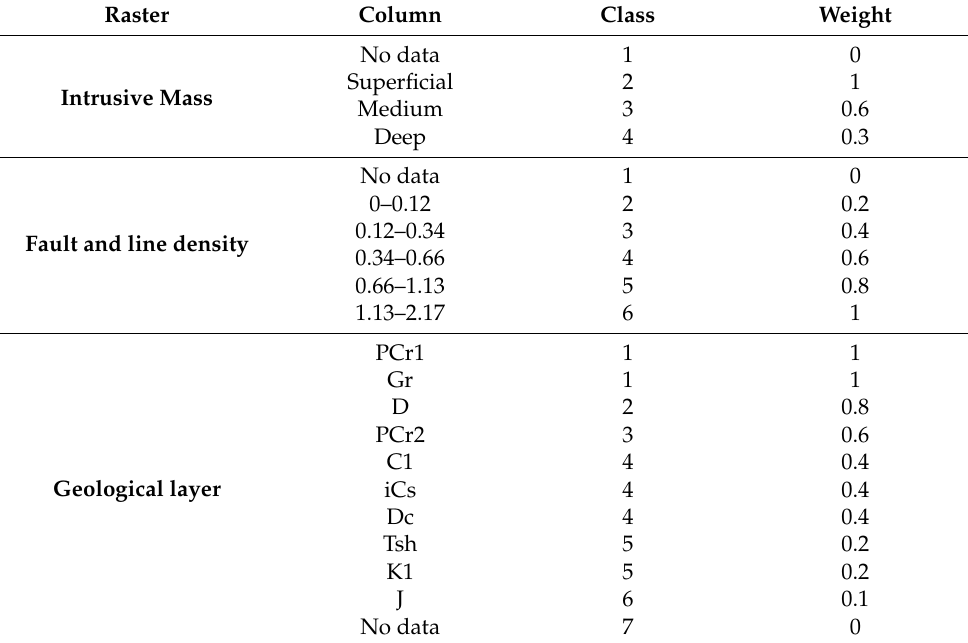
Table 2. Weighting of the classes in the fuzzy method used in this study. Raster Column Class